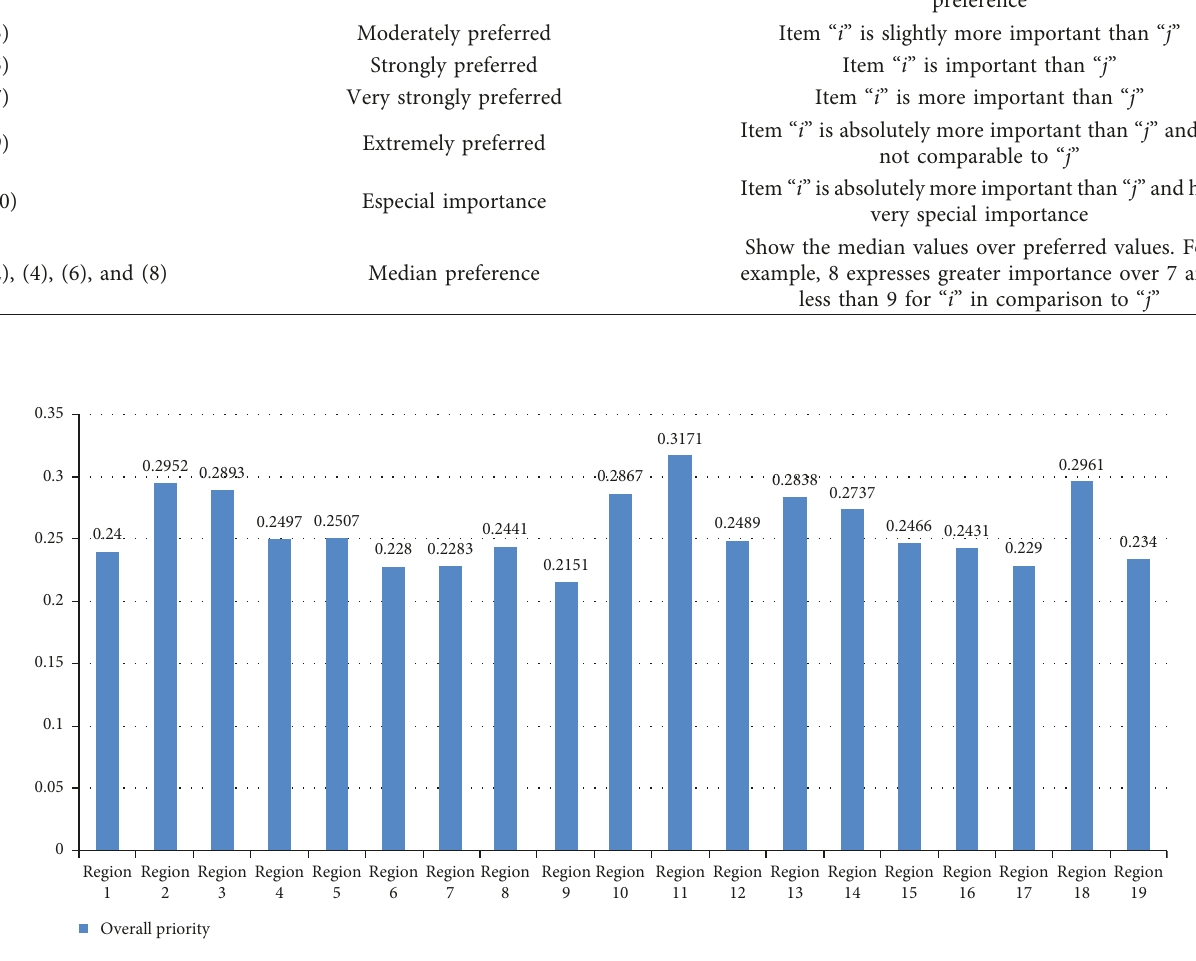
Figure 5: Overall priority of each of 19 districts of Qazvin city for physical vulnerability of the city.